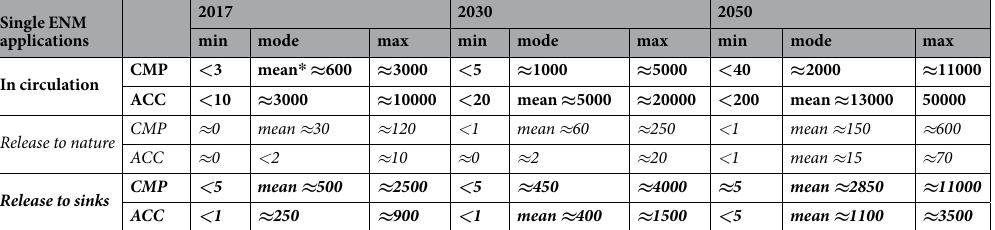
Table 3. Predicted annual mass (most probable range) in tons (see corresponding Fig. 4) of CeO 2 -engineered nanomaterial from use in single applications. CMP stands for chemical-mechanical polishing, ACC for automotive catalytic converters. In bold: mass in circulation (release delay during product use); italic: release mass to nature; and bold italic: ENM mass deposited or eliminated in technical treatment (landfilling, recycling, waste incineration, and sewage treatment). * If no clear tendency there for mode